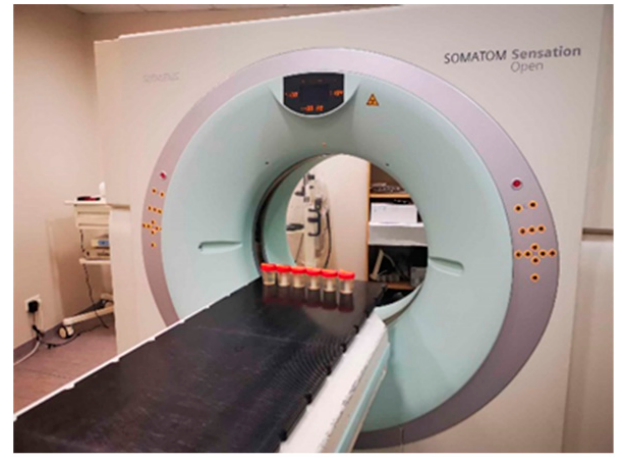
Figure 12. X-ray CT scanning set up for irradiated